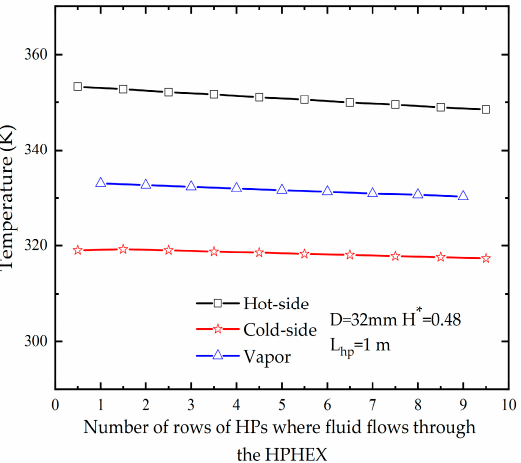
Figure 6. The temperature change trend of hot side and cold side flowing through the HPs, together with that of vapor in HPs. (The inlet mass flow rates at the hot side and cold side of the HPHEX are 1.3 and 2.9 m 3 /h, respectively.)